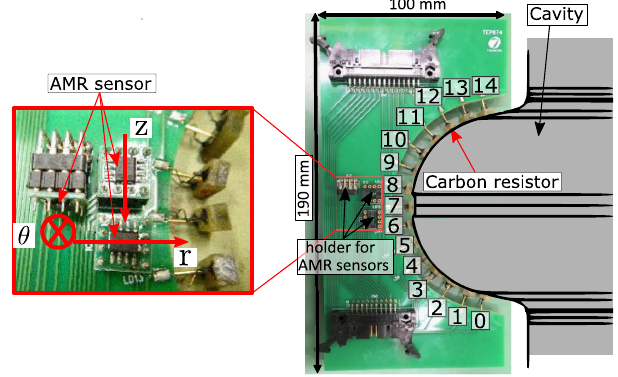
FIG. 2. Magnetic field and temperature mapping board. Fifteen carbon resistors ( 100 Ω , Allen Bradley) were mounted on the side of the board in contact with the outer wall of the cavity. Numbers show the locations of the surface of the cavity. Three magnetic field sensors were mounted on the center of the board. Each sensitive axis of sensors is z , r , and θ directions, respectively.